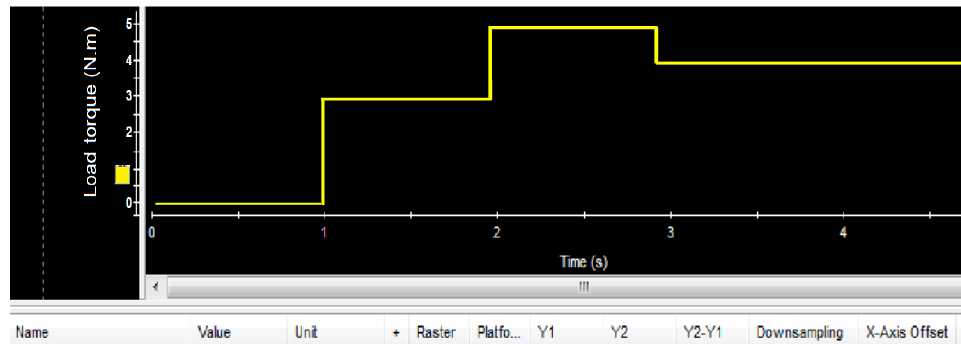
Figure 29. Hardware co-simulation of the proposed load torque (Nm).